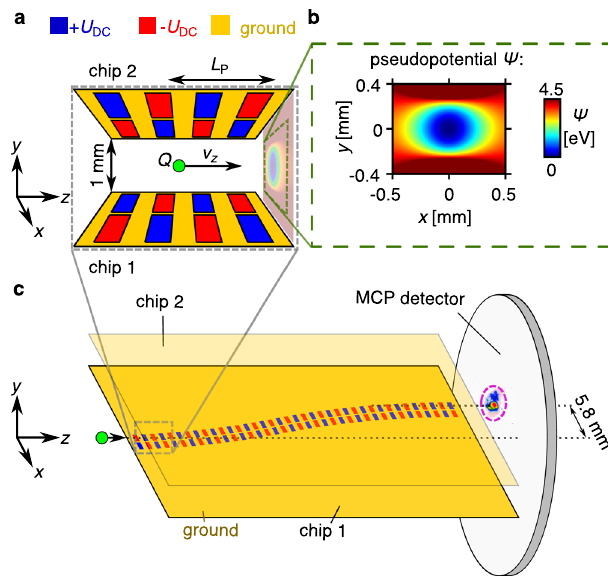
Fig. 2 Auto-ponderomotive S-curved guide. a A beam of charged particles with charge Q and velocity v z is injected into a guiding structure consisting of two planar chips facing each other with a separation of 1 mm. The chips hold electrodes to which electrostatic potentials + U DC (blue) and − U DC (red) are applied. Their polarity varies periodically along the structure with the period length L P leading to the creation of the guiding pseudopotential for propagating electrons. b Simulation of the ponderomotive potential in a cut-plane transverse to the beam for electrons with U DC = 100 V and U A = − 1 kV. The small ellipticity is due to the broken circular symmetry of the planar chips. c The electrodes on the chips de fi ne an S-curve that guides the particles so that they are laterally displaced. The particles are detected by a microchannel plate (MCP) detector 1 cm behind the structure. For illustration, only the bottom chip 1 is shown in full detail. Chip 2 has the mirrored electrode layout but with inverted polarity as shown in a . The detector signal of guided particles is highlighted by a dashed purple circle. A picture of the front and back of the upper chip is displayed in the Supplementary Fig.